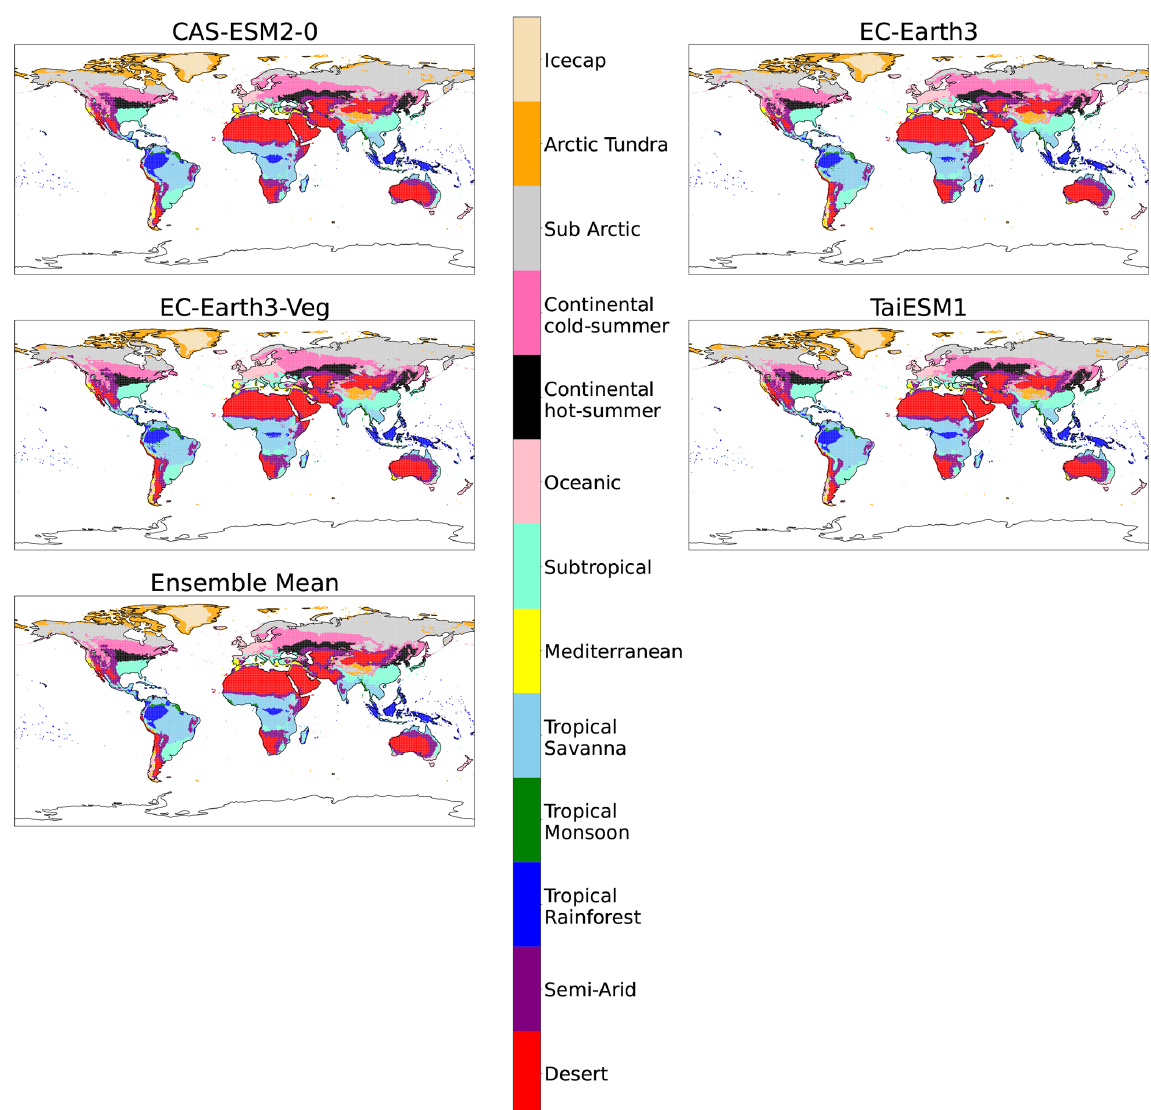
Figure B3. Maps of streamlined KG classifications for each model at + 1 . 5K with anomaly